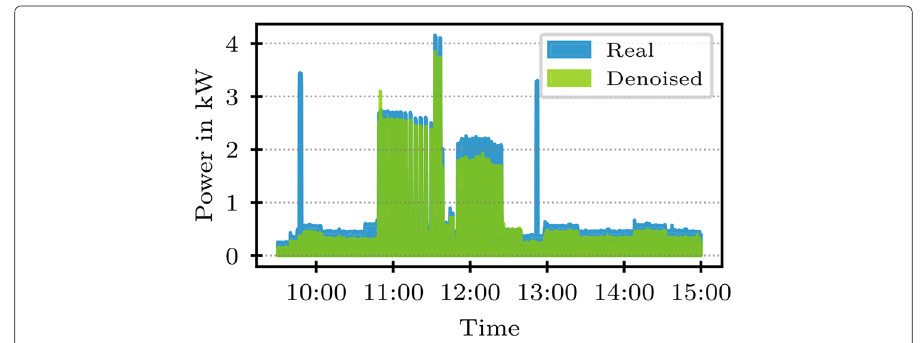
Fig. 1 Real and denoised aggregate in the case of UK-DALE house 5